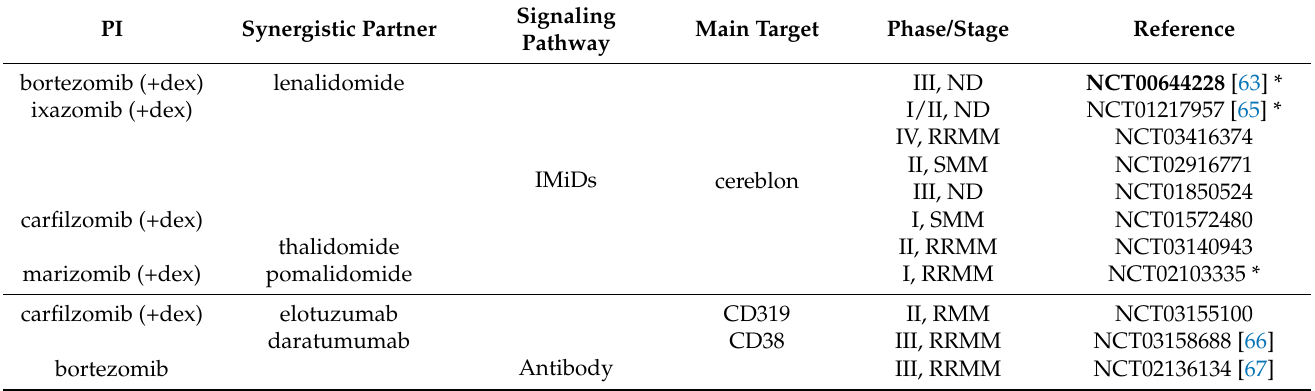
Table 1. Recent and ongoing clinical trials evaluating synergistic drug combinations with proteasome inhibitors (PI) in multiple myeloma (MM)